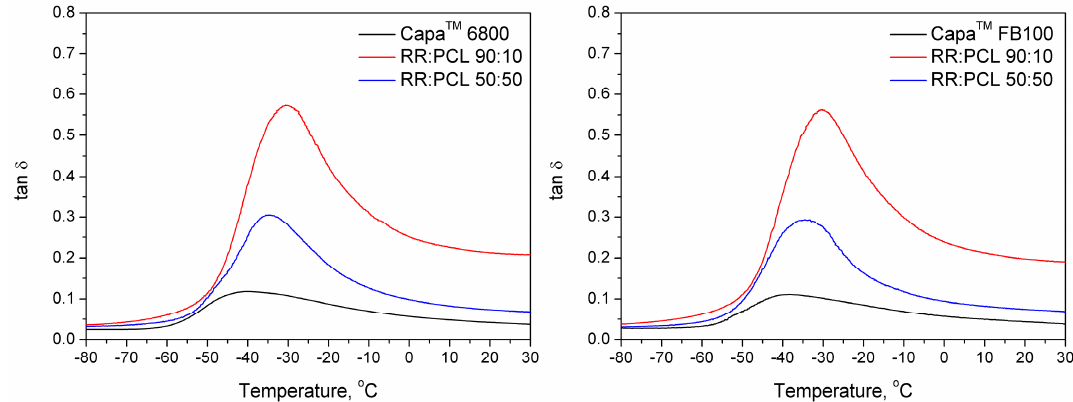
Figure 3. The loss tangent of the analyzed samples as a function of temperature.